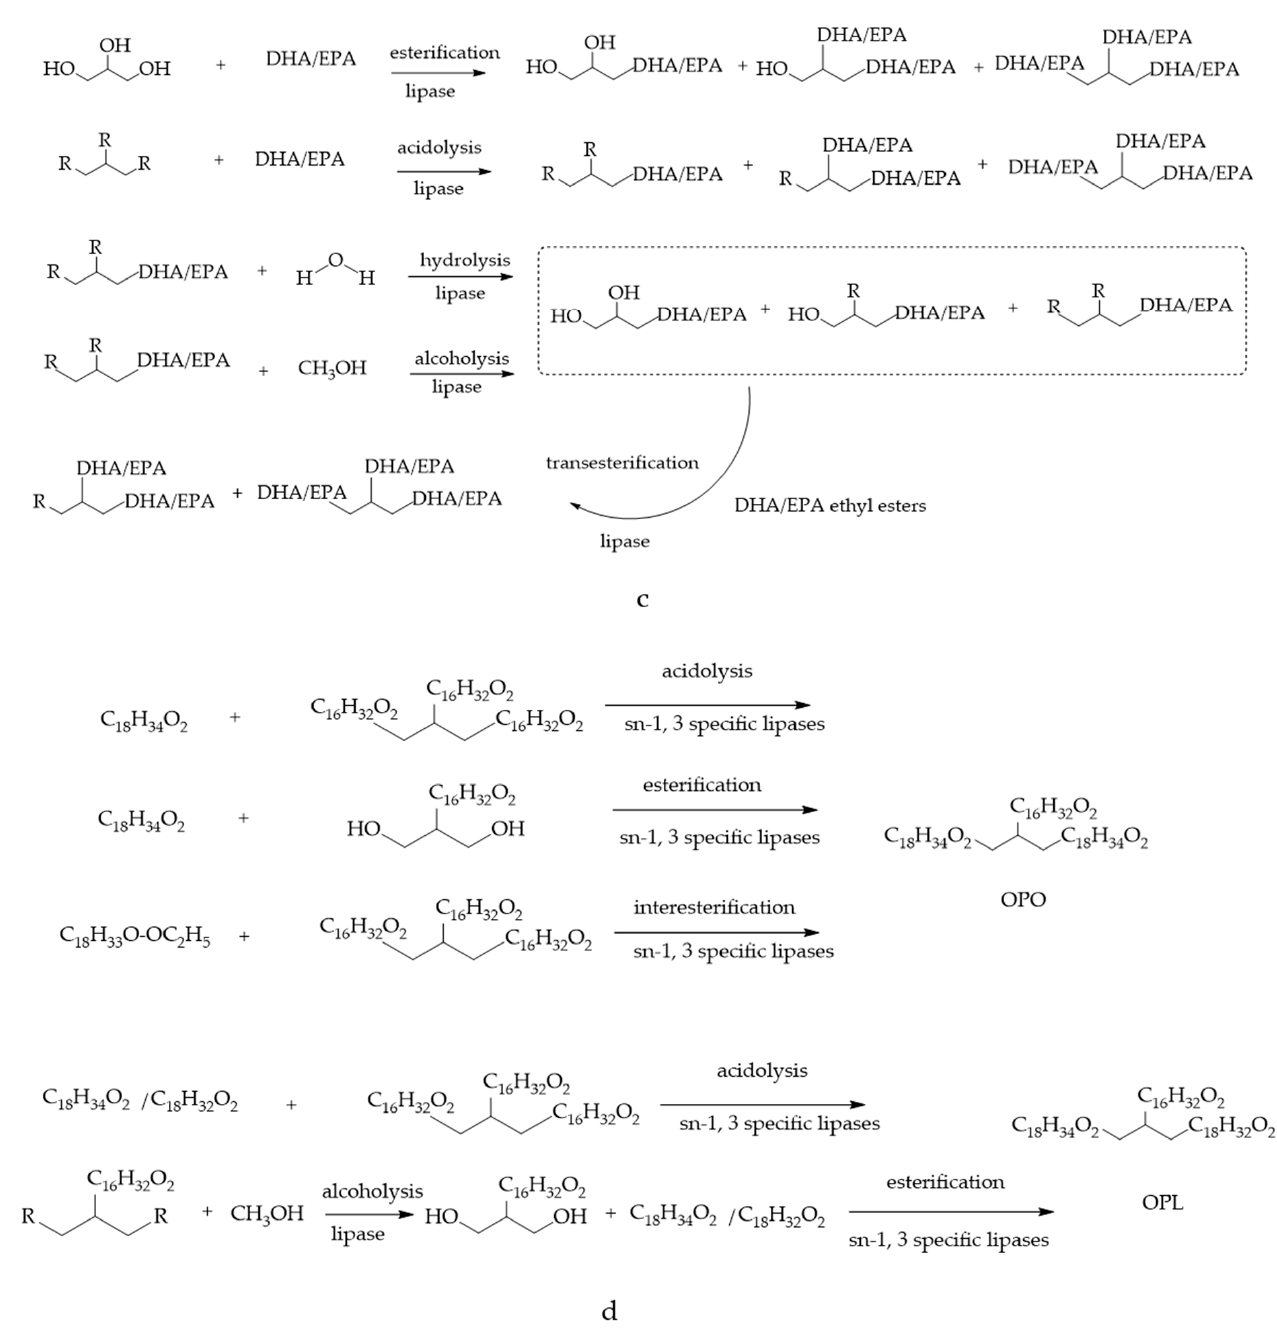
Figure 3. Approaches for enzymatic modification to obtain SLs. ( a ) The main enzymatic synthesis methods of medium-long chain triacylglycerol (MLCT) [6,41,42]. ( b ) The main enzymatic synthesis methods of diacylglycerol (DAG) [53,63,65]. ( c ) The main enzymatic synthesis methods of EPA- and DHA-enriched TAG [86,88,90,92]. ( d ) The main enzymatic synthesis methods of human milk fat substitutes [108,109]. (R, M, L, C 18 C 34 O 2 , C 16 H 32 O 2 , C 18 H 32 O 2 represent fatty acids, medium-chain fatty acids, long-chain fatty acids, oleic acid, palmitic acid, linoleic acid, respectively).